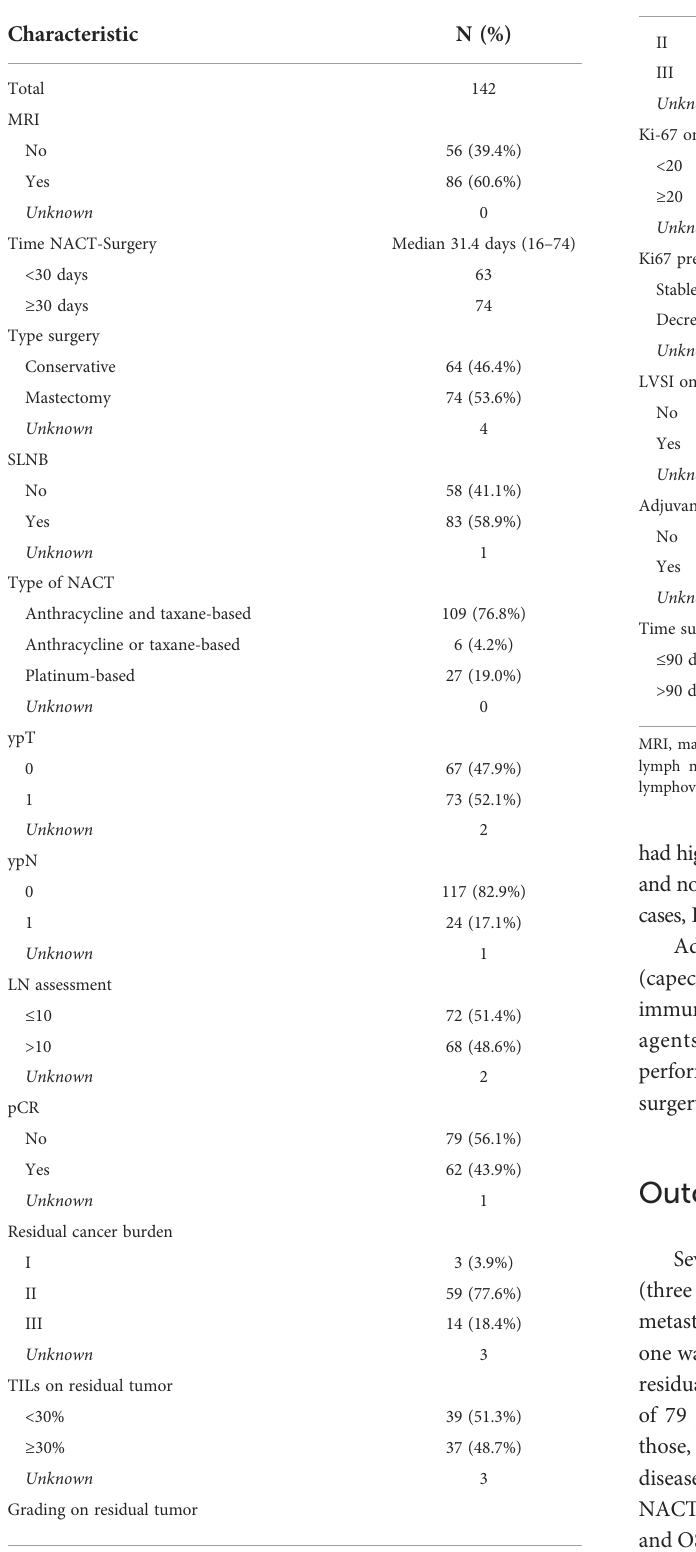
disease. As shown in Figure 1, patients who obtained pCR after